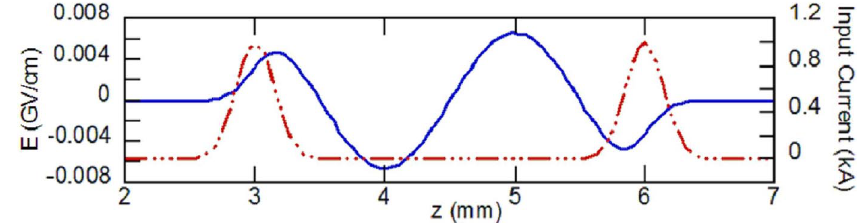
FIG. 2. (Color) Axial bunch current (dashed line) and resulting wakefield for identical bunches with plasma density such that a half-integer multiple of the plasma wavelength fits between each microbunch.